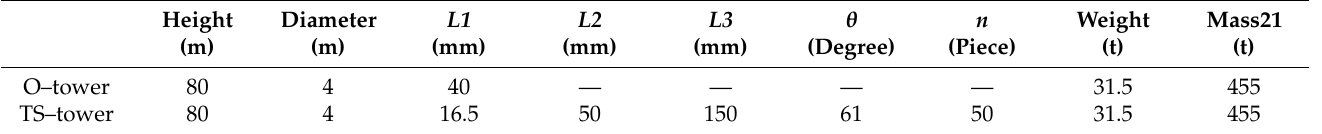
Table 4. The geometry parameters of wind turbines with the O–tower and TS–tower.